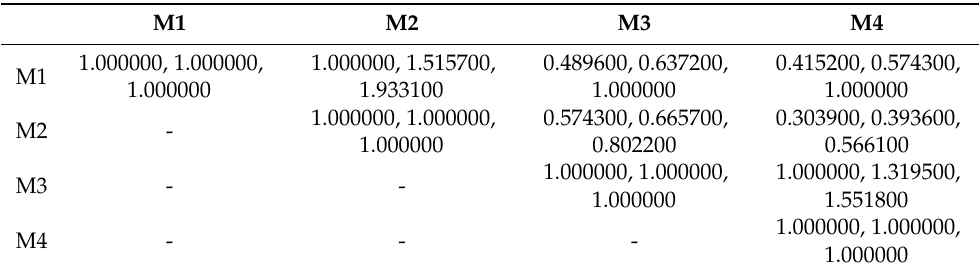
Table 4. Level 1 fuzzify consolidated pair-wise comparative